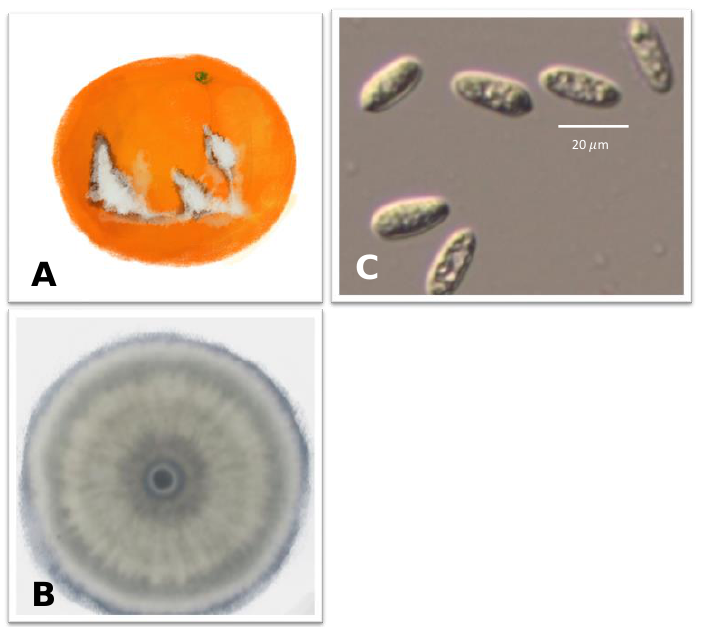
Figure 3. Black rot of citrus fruit causes by Colletotrichum gloeosporioides , ( A ) = the symptom on fruit; ( B ) = colony; and ( C ) = conidia morphology.